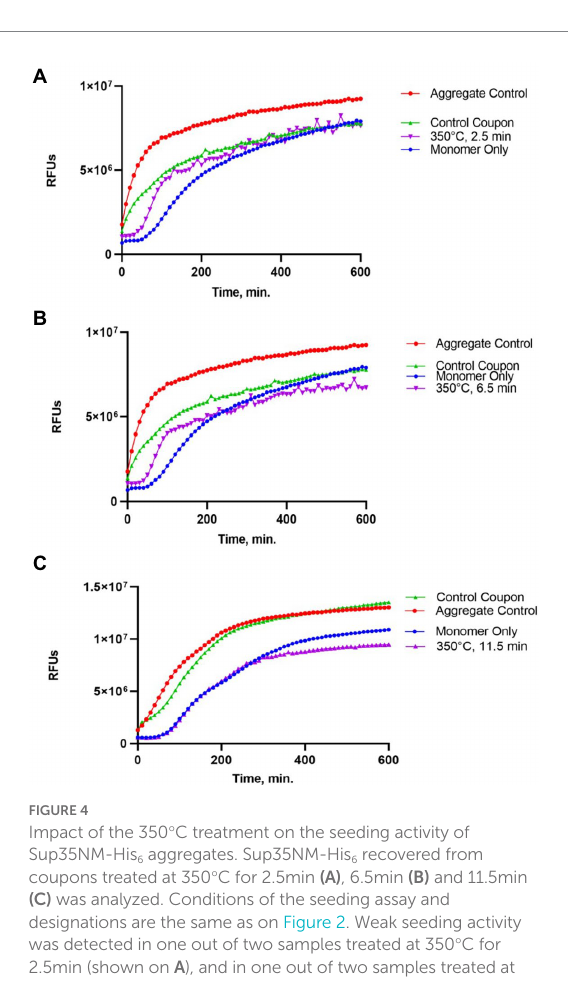
FIGURE 3 Impact of the 250 ° C treatment on the seeding activity of Sup35NM-His 6 aggregates. Sup35NM-His 6 recovered from coupons treated at 250 ° C for 2.5 min (A) , 6.5 min (B) and 11.5 min (C) was analyzed. Conditions of the seeding assay and designations are the same as on Figure 2. After 250 ° C treatment for 2.5 min (typical example is shown on A ) or 11.5 min (typical example is shown on C ), seeding activity was not detected, however it was detected in one of two samples treated for 6.5 min (shown on B ).